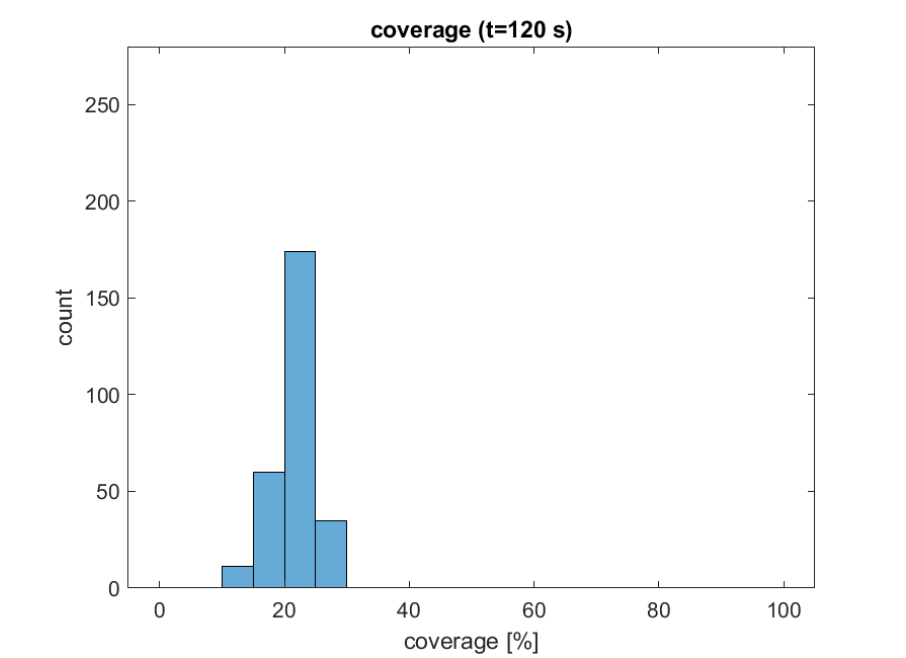
Figure 7. Distribution of coverage at 120 s of scenario